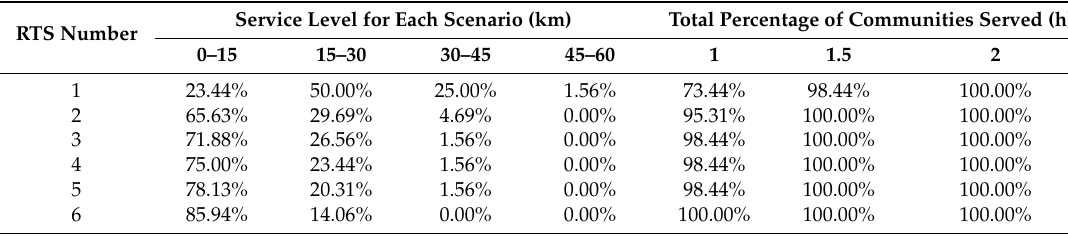
Table 3. Service level under different